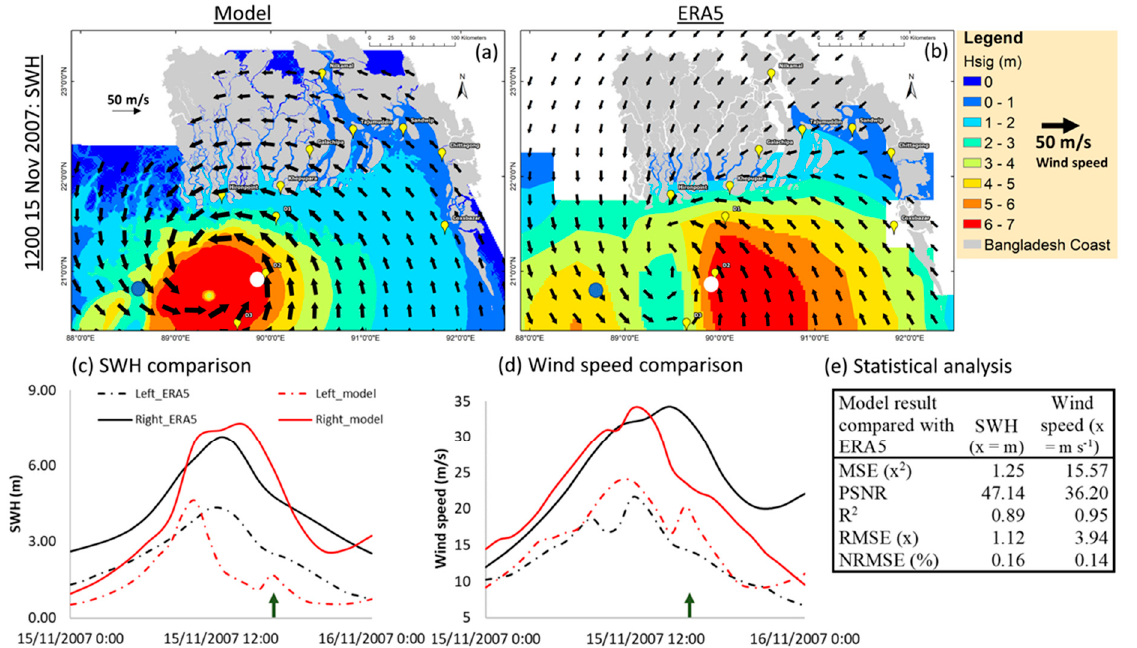
Figure 3. Comparison of the model significant wave height and wind speed with the ERA5 dataset: ( a ) modeled and ( b ) ERA5 dataset spatial variations of significant wave height and wind. Time series comparison of modeled and ERA5 at the blue (left of center) and white (right of center) dots: ( c ) significant wave height and ( d ) wind speed, ( e ) statistical analysis. N.B. The green arrow denotes the landfall time of 1500 UTC on 15 November 2007.